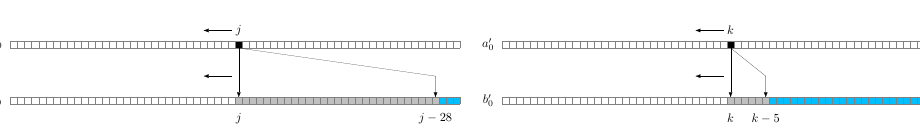
Figure 7: The grey cells at b and b ′ represent the span in the original and alternative representation of row x , respectively. The original representation (left figure) results in a 0 lower number of stable bits at b (blue cells) compared to its alternative representation on the right.